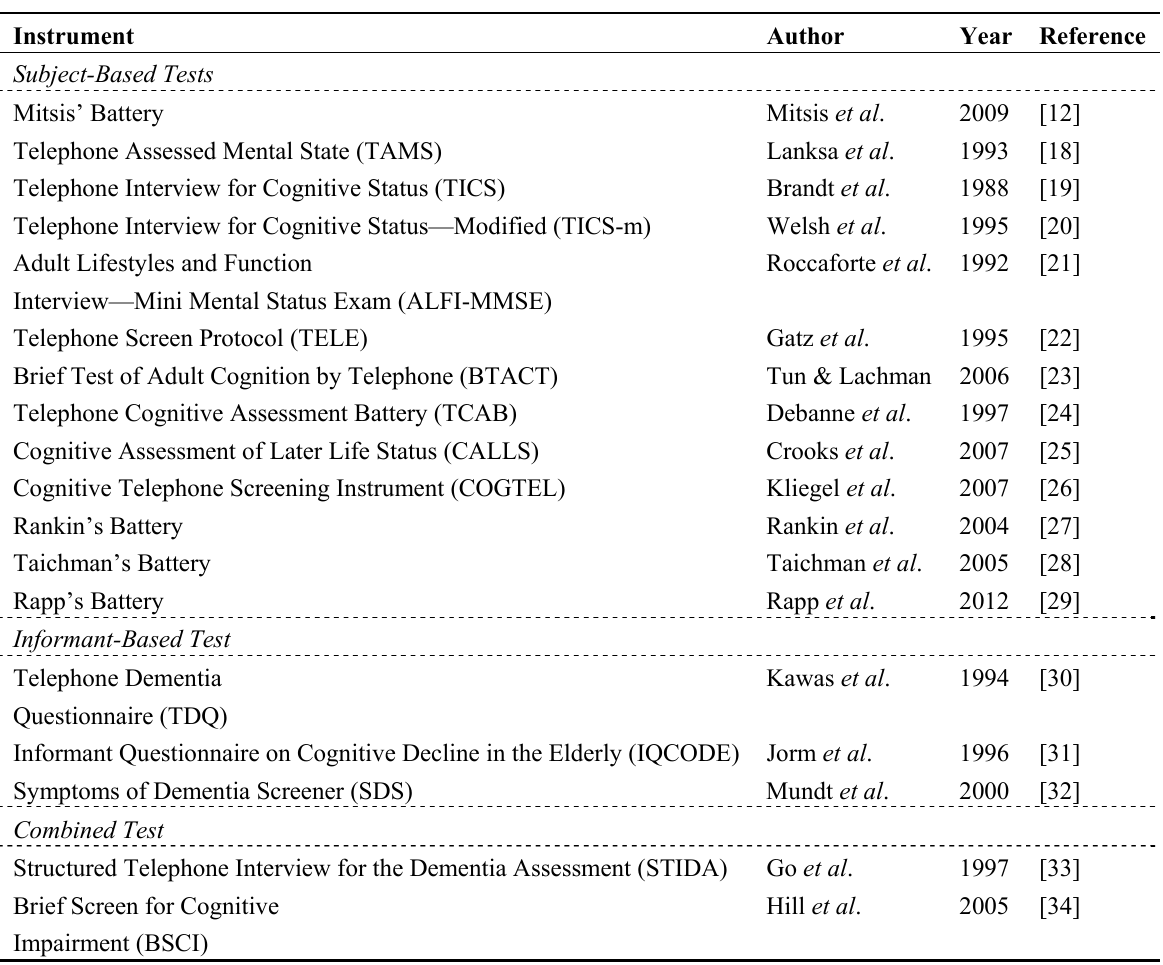
Table 1. Cognitive assessment tools administered via telephone (N =